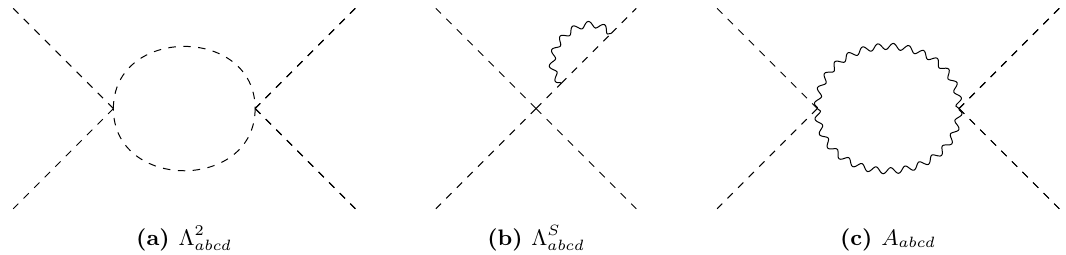
Figure 12. One-loop contributions to the running of quartic couplings with corresponding group factors e.g. in the Landau